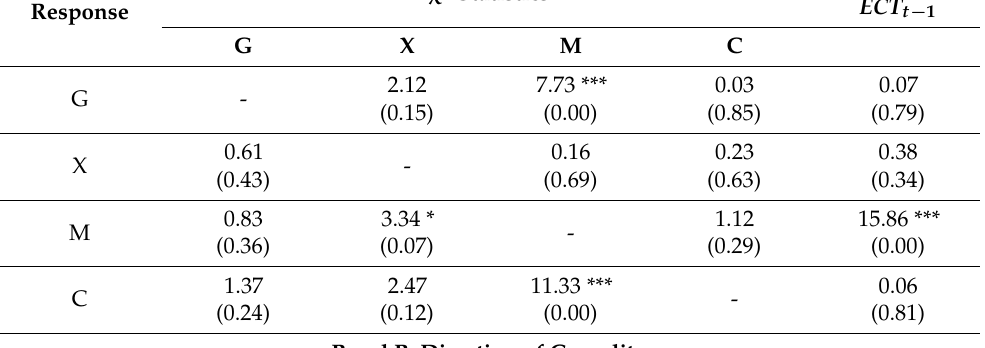
Panel B: Direction of